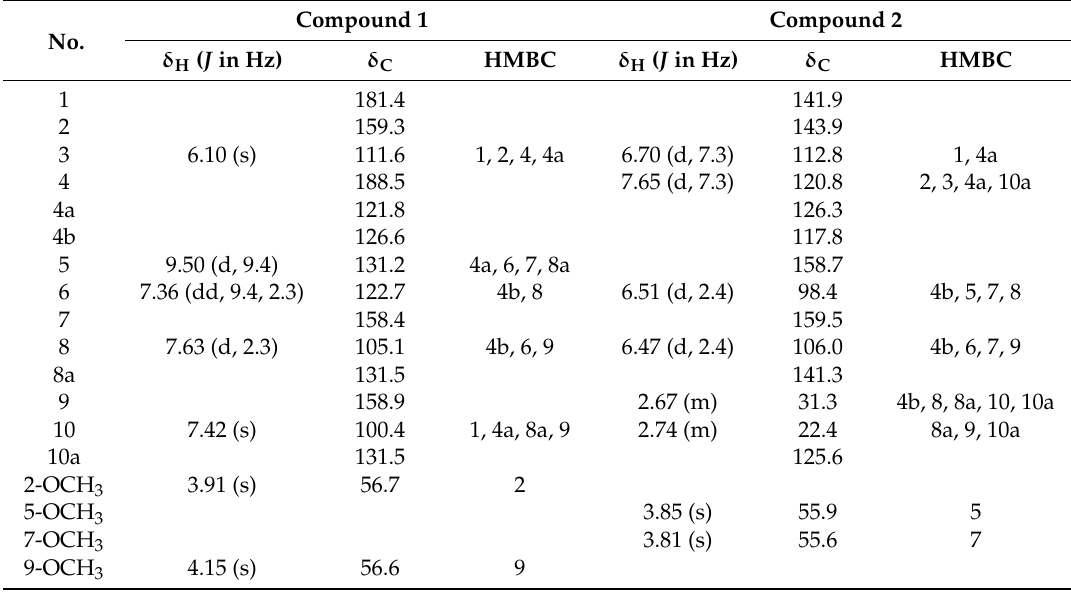
Table 1. NMR spectral data of compounds 1 and 2 (in acetone- d 6 , 500 MHz for 1 H, 125 MHz for 13 C).